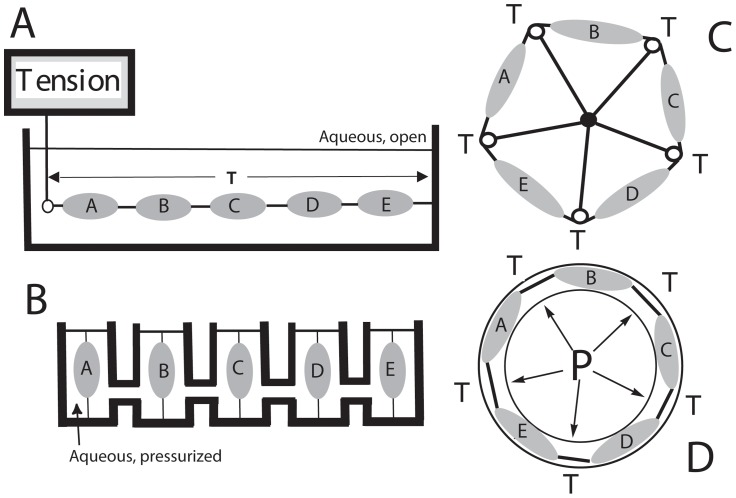
Multi-tissue, isometric contractility thought experiments.A) Isometric arrangement with tissues A–E in series. B) The hydrodynamic pressure chamber equivalent of A, where all chambers communicate through fluid filled channels. Tissues are rigidly attached below, but attached to a moveable piston at the top. C) The tissues are isometrically arranged in a circle, in analogy with A. Pulleys are between tissues, and the pulleys are supported by rigid bars. D) A schematic of the human uterus in cross section. Intrauterine pressure replaces the pulleys and rigid bars of C, and the hydrodynamics correspond with B. In both B and D, each tissue senses the same pressure.